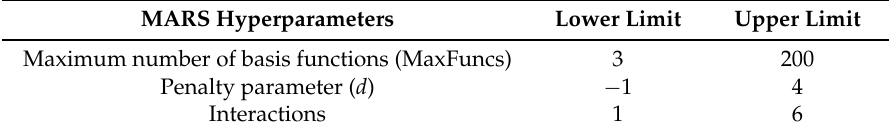
Table 4. Initial ranges of the three hyperparameters of the ABC–MARS-based model fitted in this study. MARS Hyperparameters